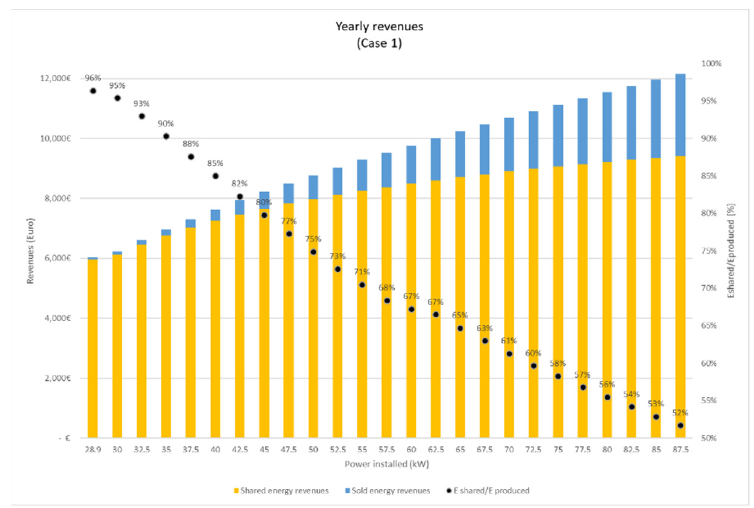
Figure 2. Community yearly revenues as a function of installed power.